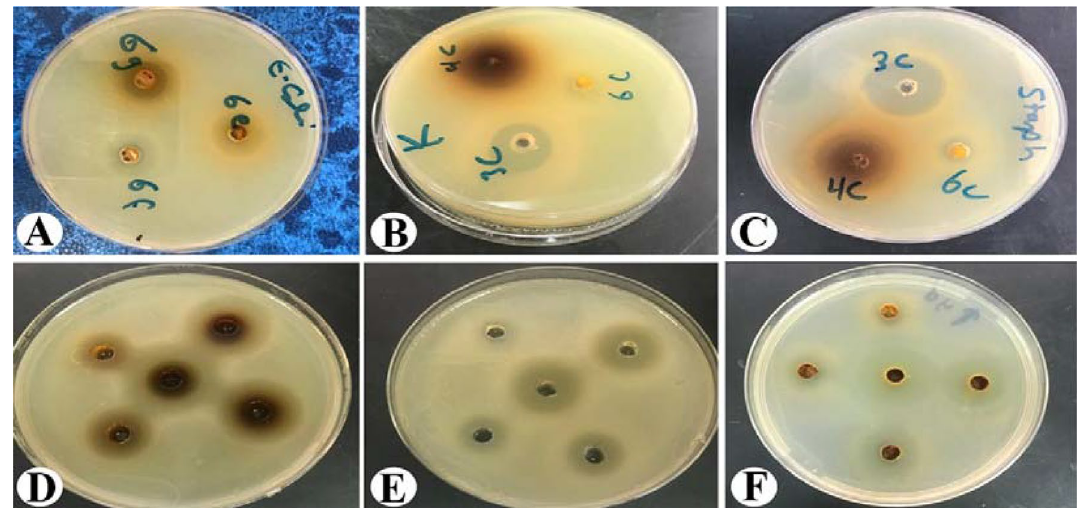
Figure 6. Sensitivity and minimum inhibitory concentration test (MIC) tests of the synthesized compounds against three clinical isolates [( A – C ) sensitivity test; ( D – F ) MIC determinations by the agar dilution method]. MIC minimum inhibitory concentration MIC by Substance code